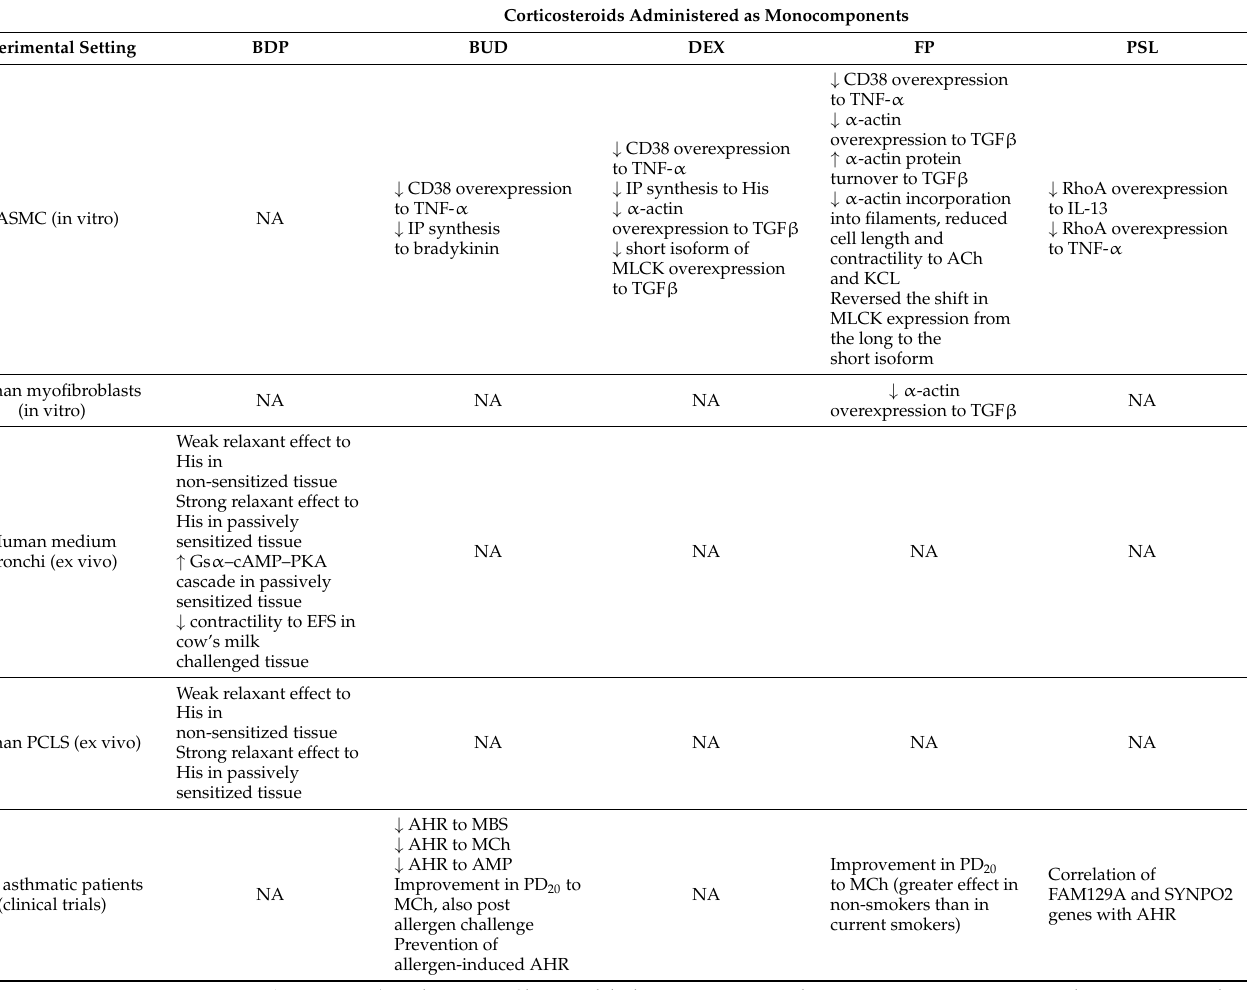
Table 2. Statistically significant ( p < 0.05) effects of specific CS administered as monocomponents against human ASM contractility and AHR in vitro, ex vivo, and in clinical trials as resulting from this systematic